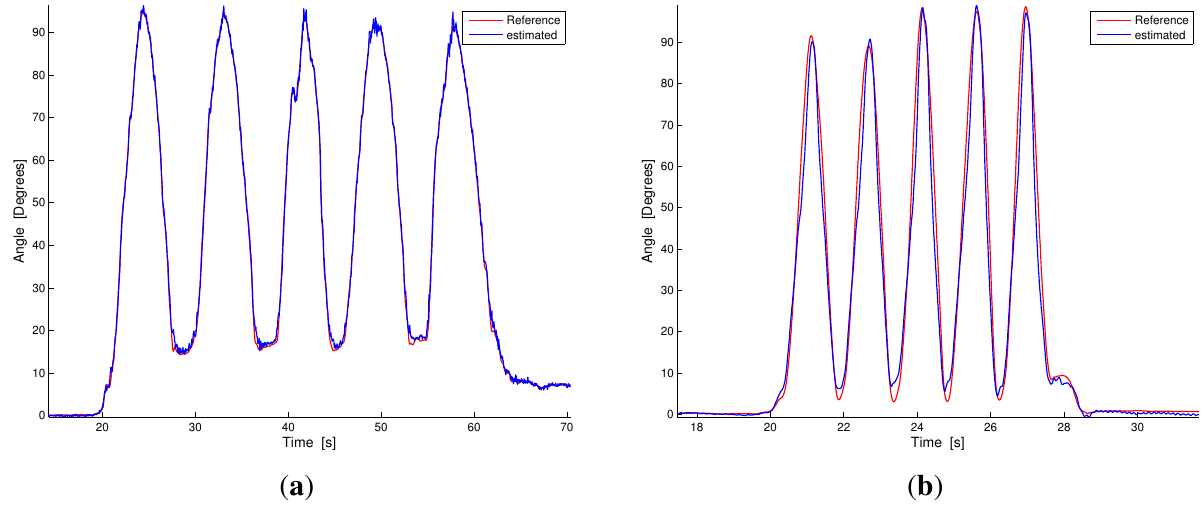
Dynamic comparison between our estimation technique and the reference measurement during contralateral monopodalic standing tasks with different knee flexion-extension velocities. The blue line represents our estimation, while the red line is the reference measurement. ( a ) Slow knee flexion; ( b ) Fast knee